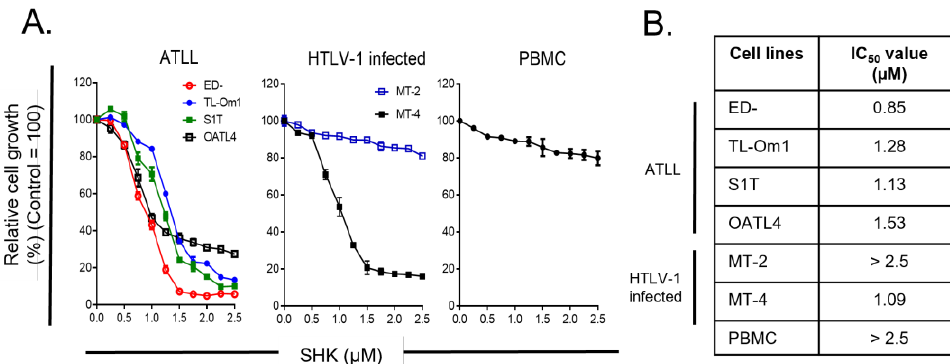
Figure 1. Anti-proliferative effect of SHK on ATLL. ( A ) ATLL, HTLV-1-infected cells and PBMC were treated with or without SHK for 24 h, and cell proliferation ability was measured by MTT assay (mean ± SE). ( B ) IC50 values were analyzed using GraphPad software.